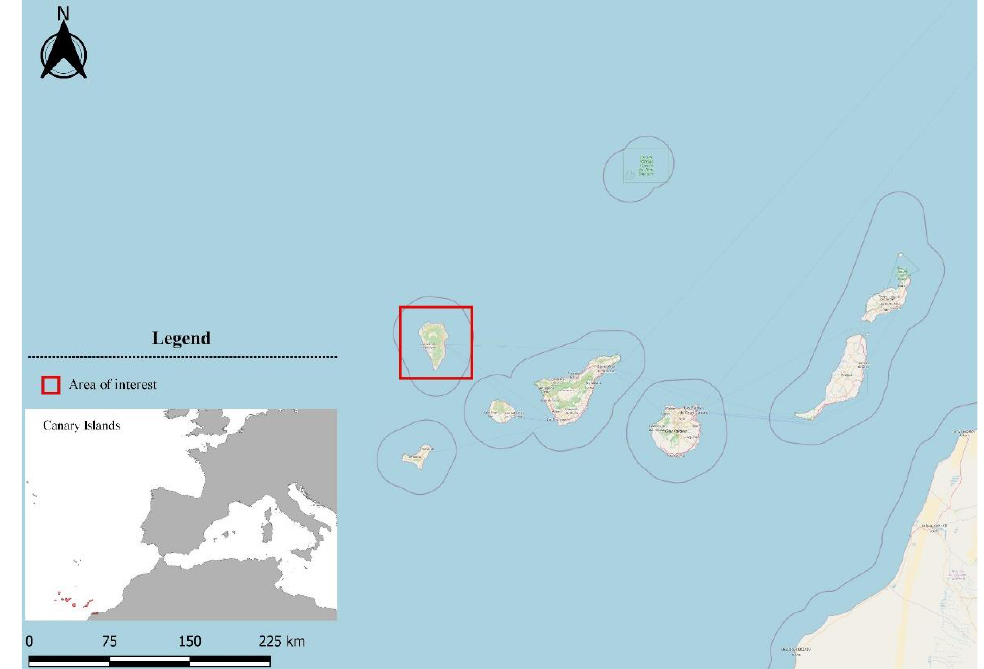
Figure 1. Location of La Palma island within the Canary archipelago.